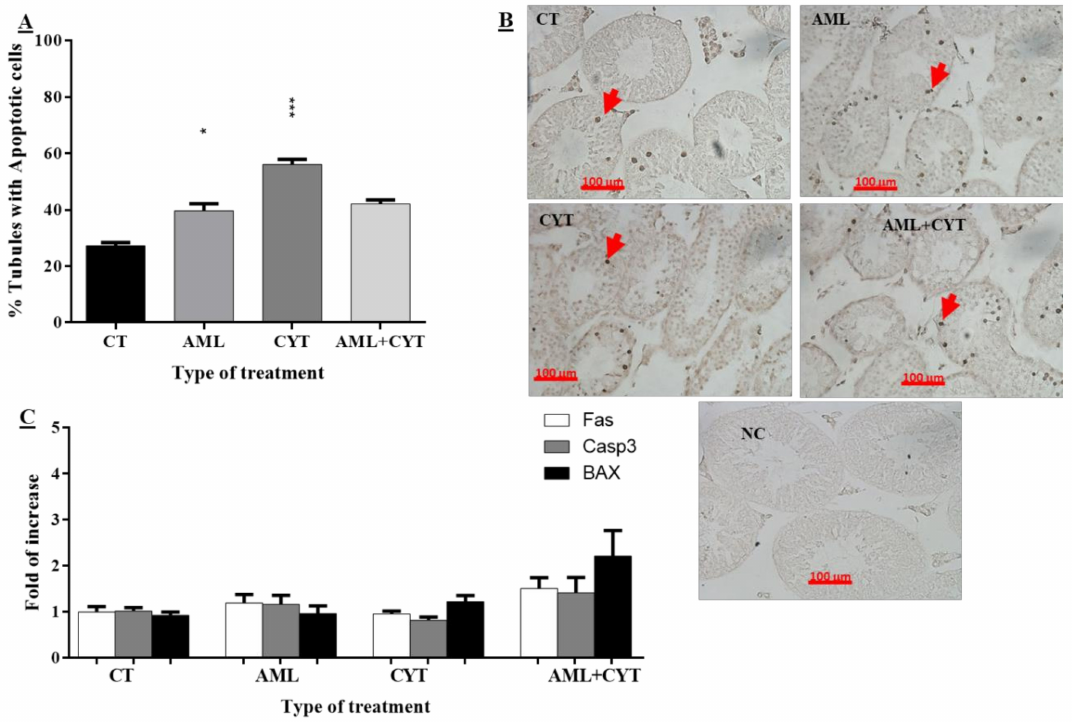
Figure 3. Effect of AML and CYT on apoptosis of spermatogenic cells in testicular tissue of immature treated mice. Mice were treated as described in Figure 1. Testes were removed after 2 weeks and fixed or used for RNA extraction. Fixed testicular tissues were examined by TUNEL assay to identify apoptotic cells. Apoptosis is defined as tubules with apoptotic cells and presented as the % of tubules with apoptotic cells. TUNEL assay ( A ) and quantification of staining ( B ). The RNA expression levels of Fas, Casp3 and BAX in the testes isolated from each treatment group were examined by qPCR analysis using specific primers, and housekeeping gene (GAPDH) was used as internal control. The results are presented as fold of increase compared to GAPDH ( C ). N (number of repeats of all treatments) = 3; n (number of mice examined from all the experiments for each treatment (TUNEL assay) = 6–7/group; #tubules/group = 40–100; n = 5–7/group (RNA expression). * ( p < 0.05), *** ( p < 0.001) significant relative to control